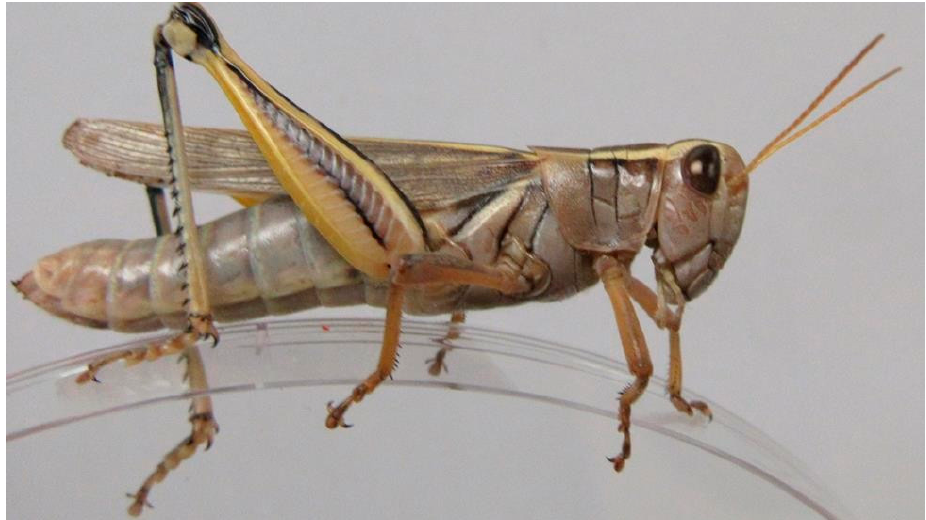
Figure 2. Female Melanoplus bivittatus . (Wahid Dakhel, 2014). University of Wyoming, Laramie, WY, USA.